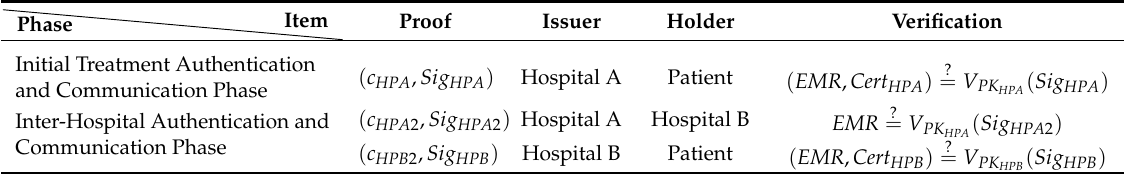
Table 1. Non-repudiation of the proposed